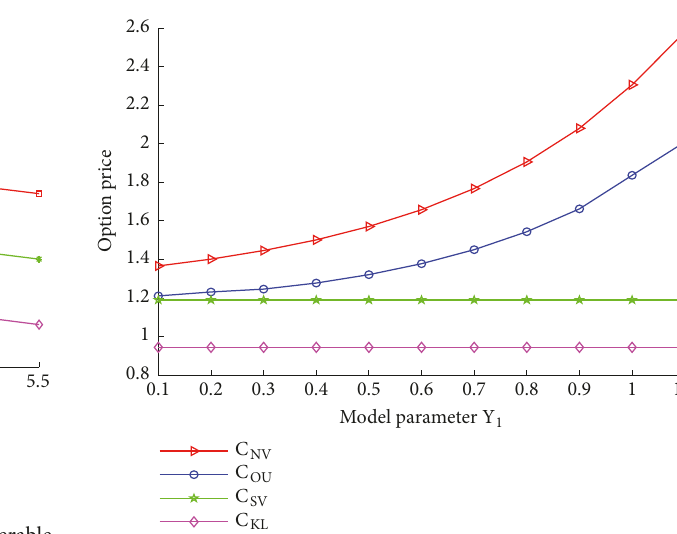
Figure 9: The effect of 𝑌 1 on the option